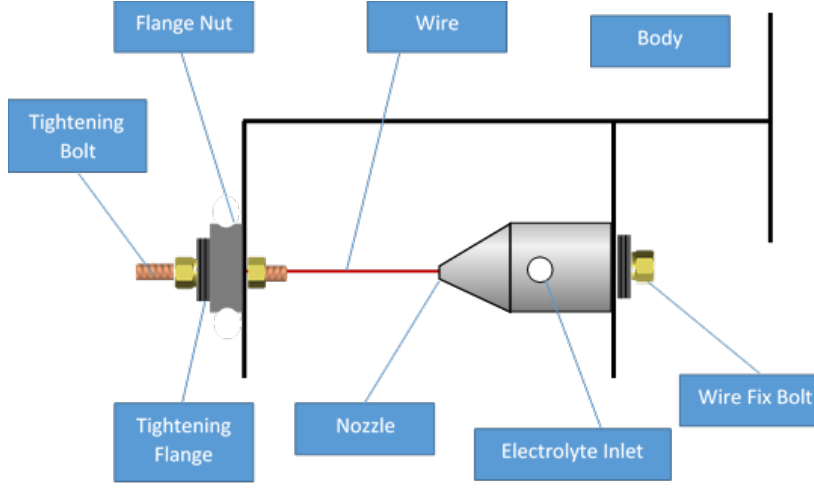
Figure 1: Tool holder